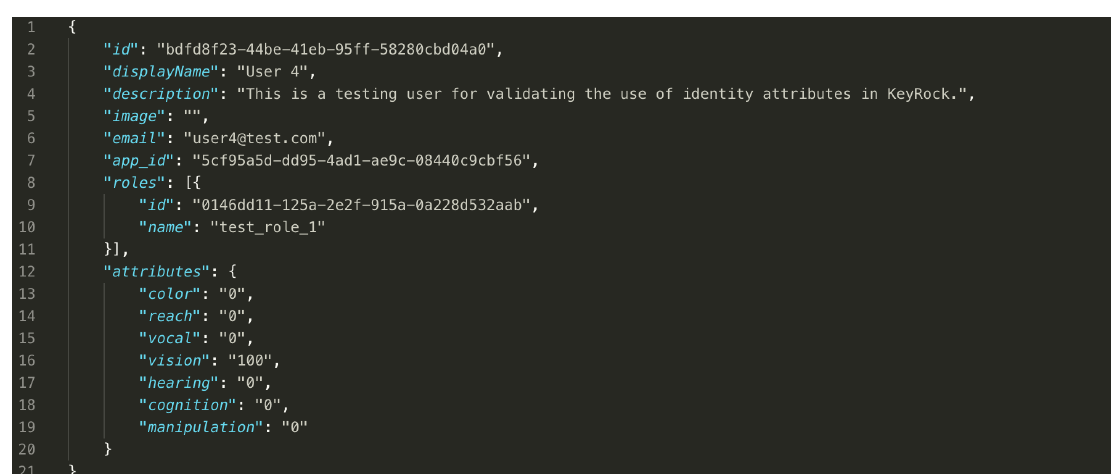
Figure 5. Keyrock’s interface for defining functional attributes.